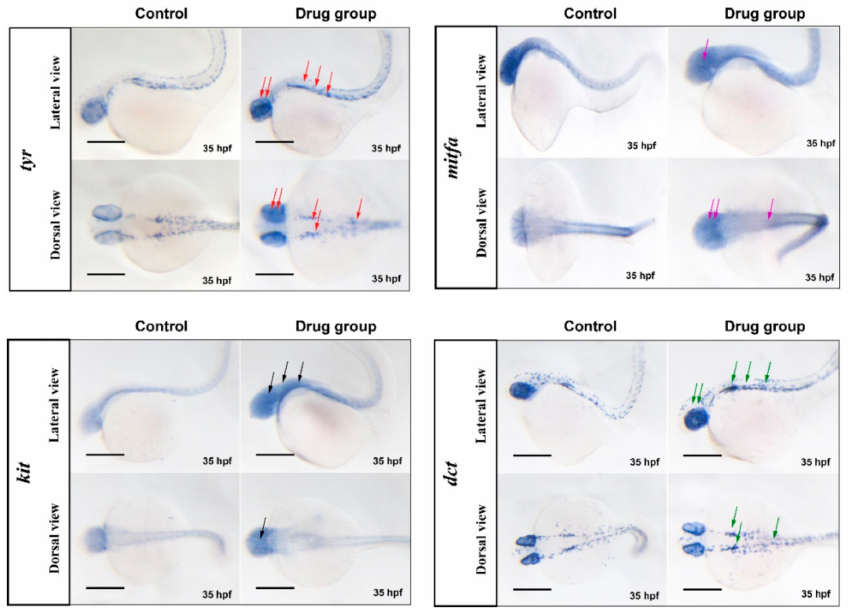
Figure 11. Combination compounds enhance the expression level of melanogenic genes. By the method of in situ hybridization on whole-mount zebrafish embryos to investigate the effects of the best drugs combination on the expression of melanogenic genes ( tyr , mitfa , kit and dct ). Ze- brafish larvae were incubated with combination of butin, caffeic acid and luteolin (butin:caffeic acid:luteolin = 7.38:28.30:64.32). In 35 hpf, collecting zebrafish and hybridizing with labeled nucleic acid probes. The color rendering (blue) is means expression of specific genes, the red, purple, black and green arrows indicate the expression sites of tyr, mitfa, kit, and dct, respectively. The scale bars represent 300 µ